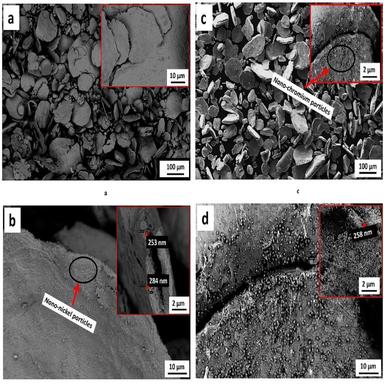
Powder morphologies and plating layers of (aeb) f-CuAgNi and (c) f-CuAgCr powders.